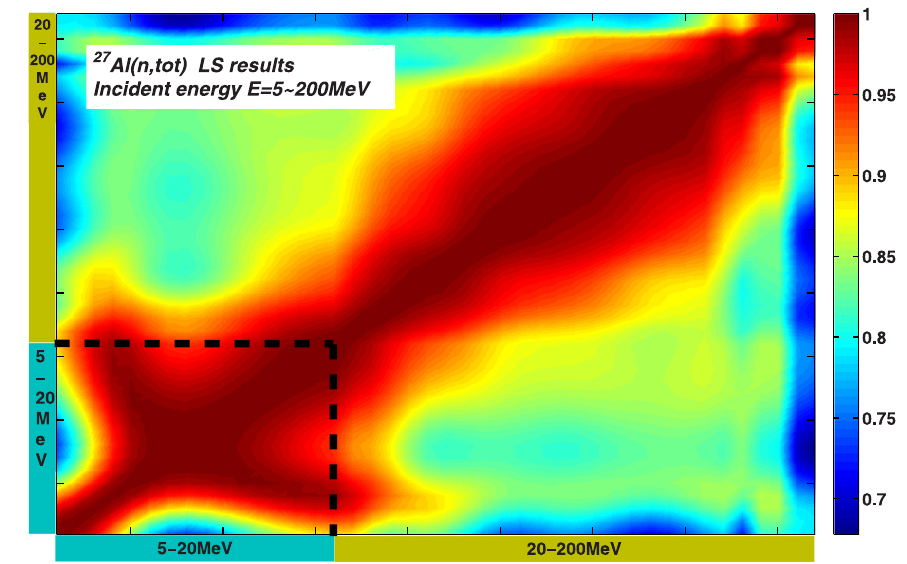
Fig. 8. The correlation matrix of the 27 Al(n,tot) cross